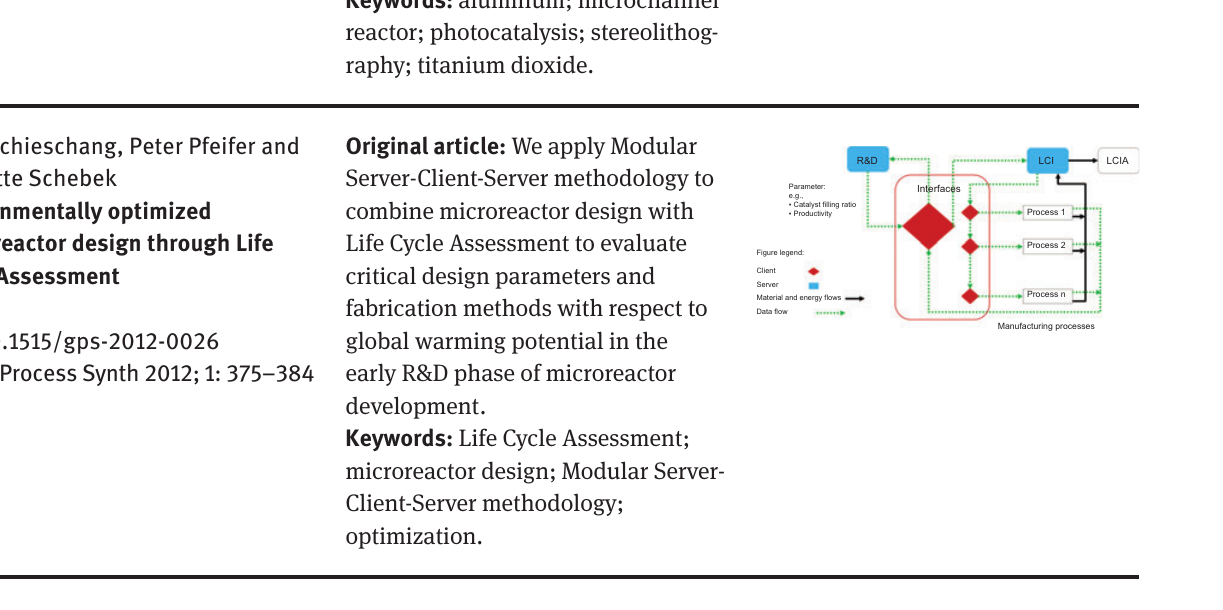
Figure legend: Client Server Material and energy flows Data flow